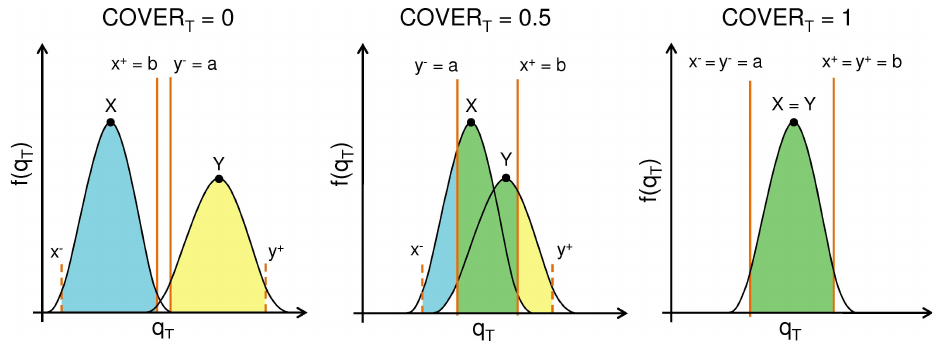
Fig. 4. Schematic confidence intervals overlap criteria: COVER T . X is the model estimate computed on the sub-period 1 with confidence interval [ x − ; x + ] and Y is the model estimate computed on the sub-period 2 with confidence interval [ y − ; y + ] . a is the highest value of the lower limit of confidence intervals and b is the lowest value of the upper limit of the confidence intervals. Three cases are shown: COVER T equal to 0 (null overlap), 0.5 (half overlap) and 1 (total overlap).